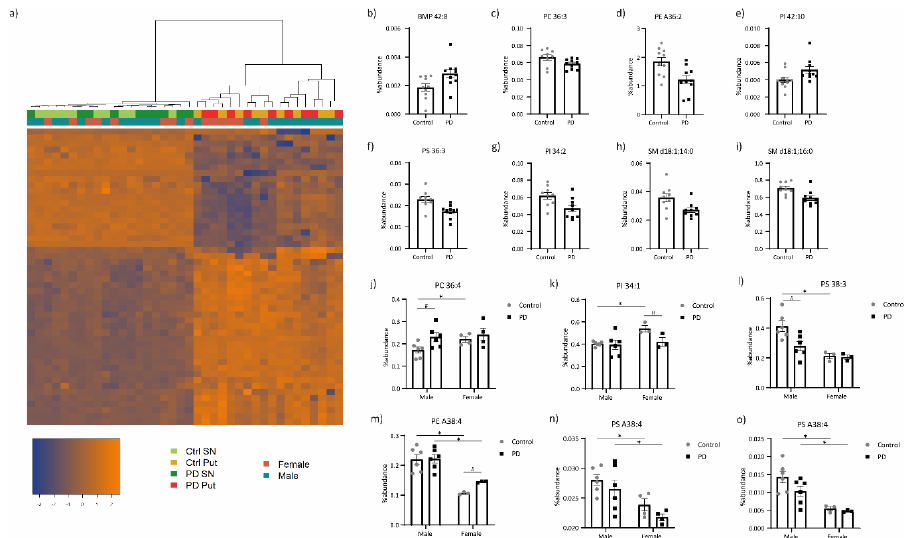
Figure 1. Lipid profiling of the SN and putamen from PD patients compared to controls. ( a ) Hierarchical clustering of the samples based on the different abundances of lipid species. Percentage of abundance of lipid species that differ between PD patients and controls, according to at least two of the three selection criteria, in ( b – f ) SN and ( g – i ) putamen, and between male and female controls, and also in ( j ) SN and ( k ) putamen of male PD patients compared to controls, or in ( l ) putamen of female PD patients compared to controls. Percentage of abundance of a lipid that ( m ) has different abundances in both males and female controls, and male and female PD patients, together with a difference in female PD patients compared to controls, and that is lower in females than in males, both in controls and PD patients, in ( n ) SN and ( o ) putamen. BMP, Bis(Monoacylglycero)Phosphate; PC, phosphatidylcholine; PE, phosphatidylethanolamine; PI, phosphatidylinositol; PS, phosphatidylserine and SM, sphingomyelin, where d18:1 indicates the common sphingosine base c.f. standard nomenclature [45]. Sample values are plotted individually. ‘A indicates that the sn-1 position is linked via an ether linkage. Numbers (X:Y) represent the number of carbons (X) and double bonds (Y). # Differences between control and PD samples, within one gender; * differences between male and female samples, within one condition.